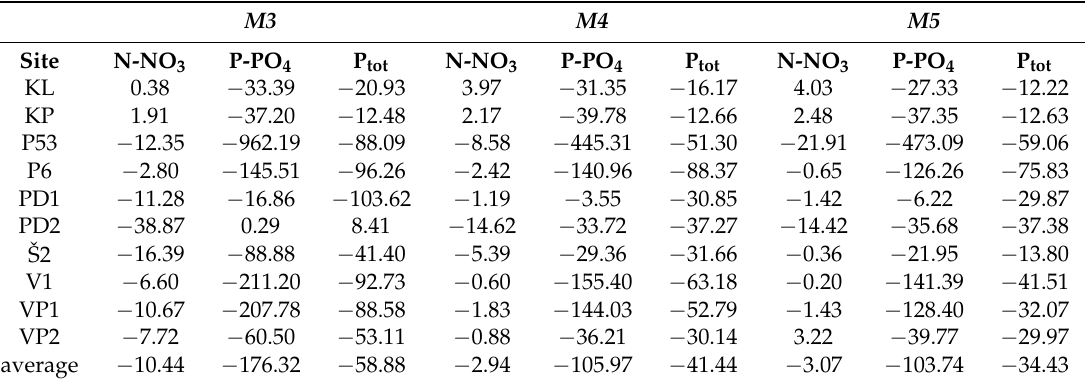
Table 5. Average monthly accuracy (%) of the M3 to M5 algorithms related to the true load (M6) for all the substances, sites, and monitored periods.